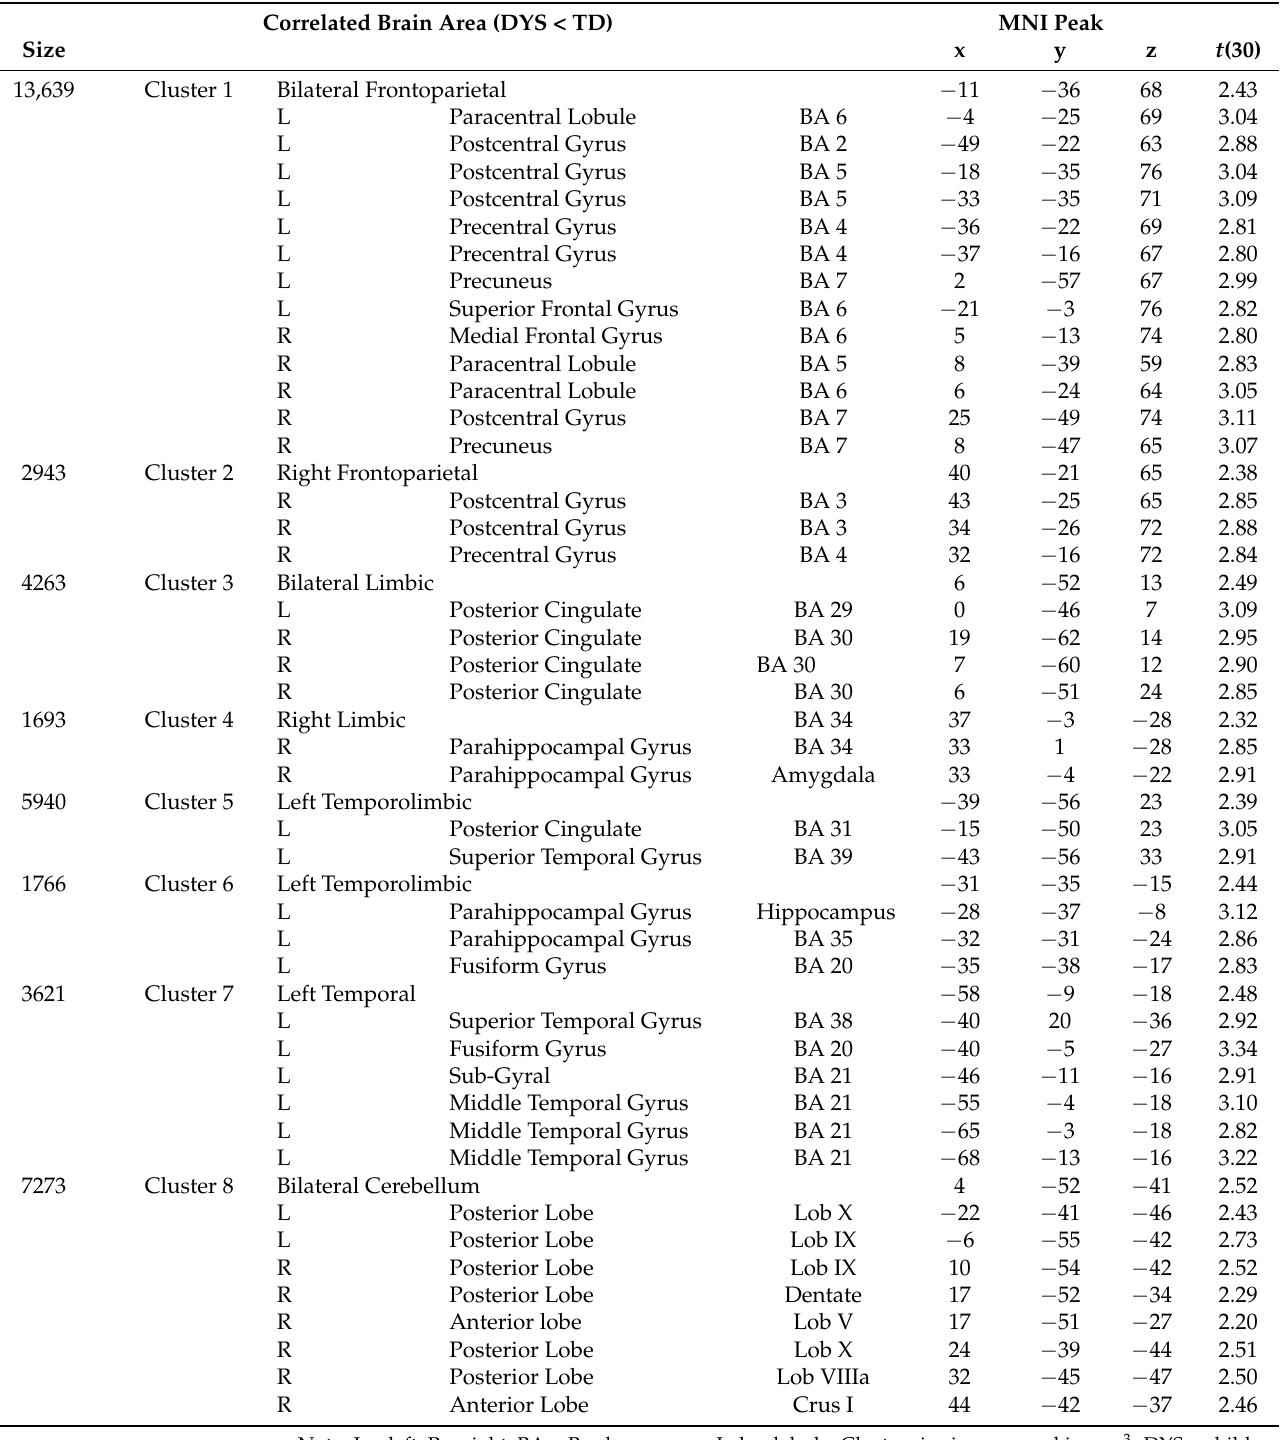
Table 2. Significant effect of group for the connectivity maps of the GMFA seed region (whole- brain